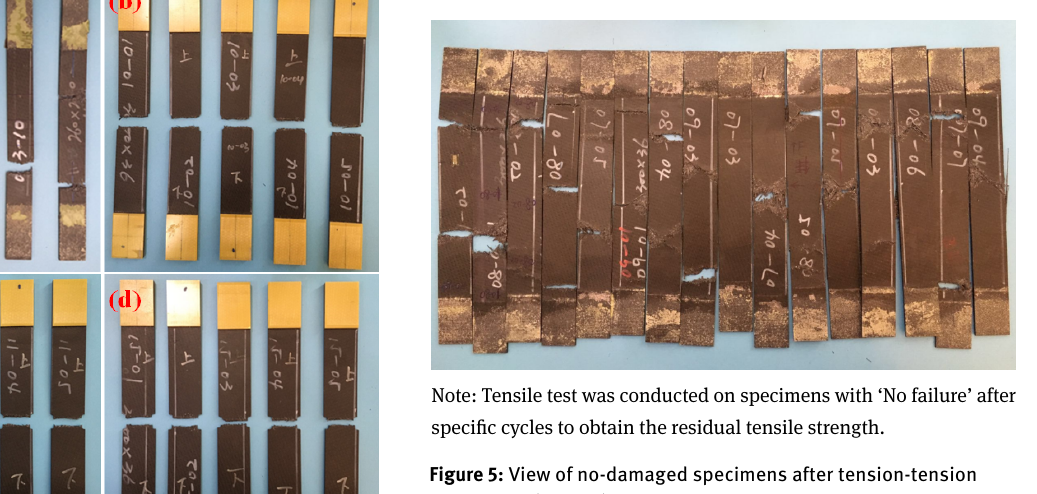
Figure 5: View of no-damaged specimens after tension-tension fatigue test ( R =0.05)